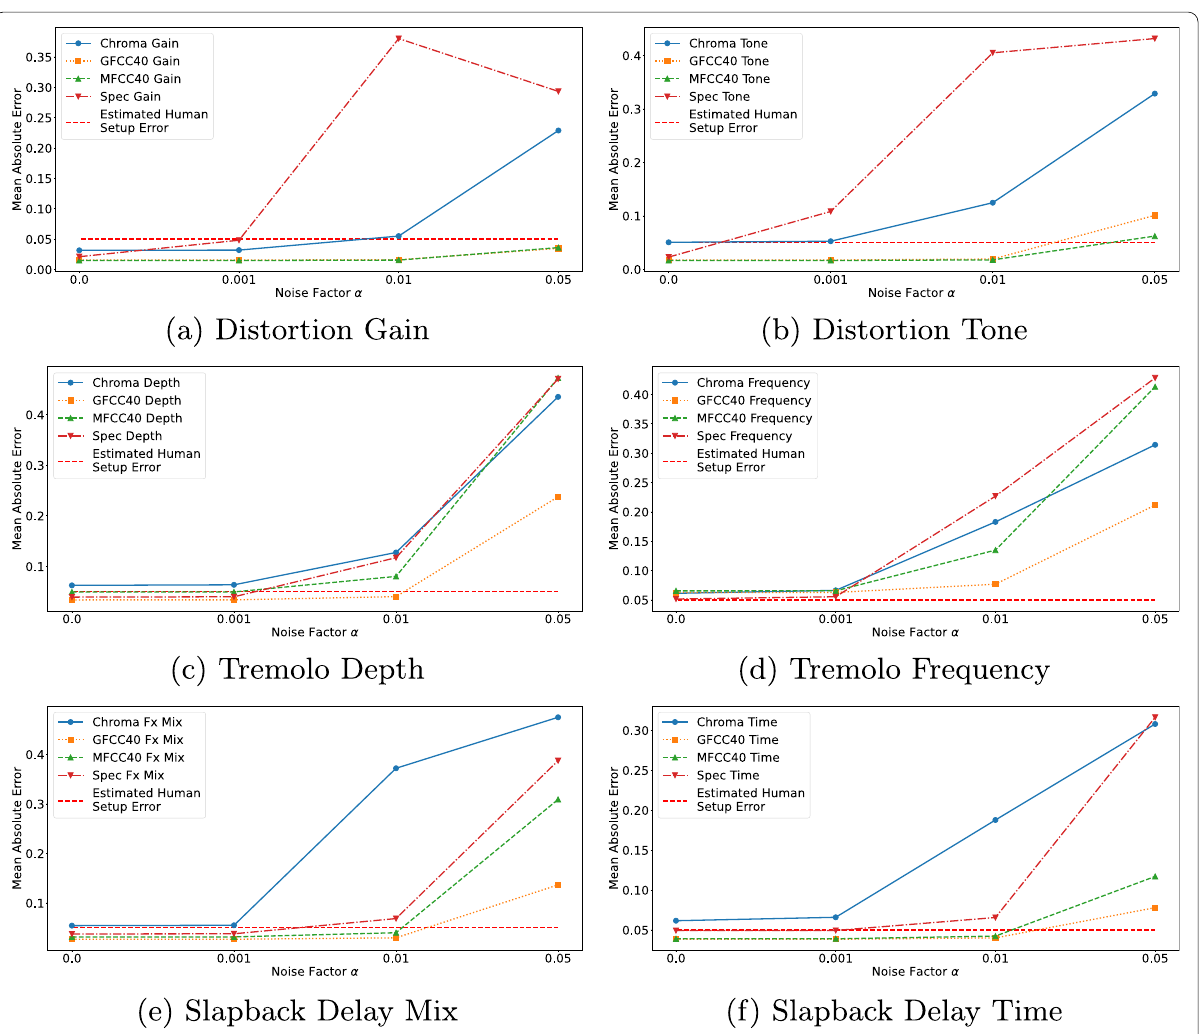
Fig. 13 Mean absolute error of the parameter extraction of the convolutional neural network across background noise levels for the a , b distortion, c , d tremolo, and e , f slapback delay effect and all investigated time-frequency representations. The noise factor α was described in Section